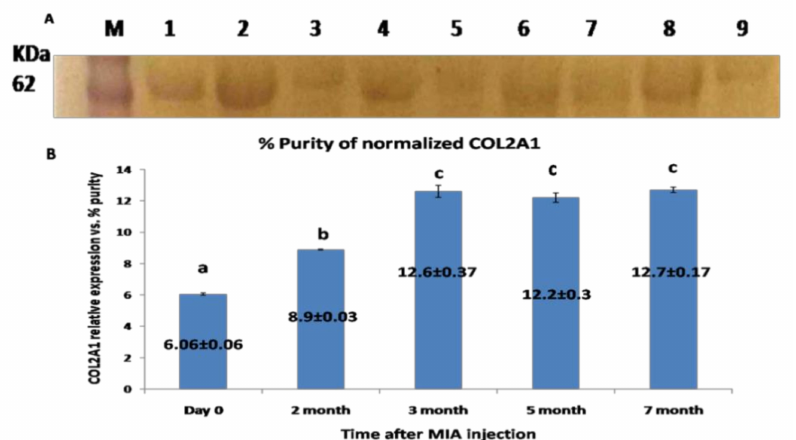
Figure 6. ( A ) Western blot membrane representing the specific band for COL2A1 protein from the synovial fluid; located at MWT, about 65 KDa. (M): pre-stained protein marker; lanes 1, 2 representing samples at day 0 (control); lanes 3, 4 representing samples for the 2nd month; lane 5: samples at the 3rd month; lanes 6 and 7 samples at the 5th month; and lanes 8 and 9 corresponding to the 7th month. ( B ) Graphical representation for the level of COL2A1 protein expression level relative to total protein Coomassie blue staining) as quantified by densitometric analysis of the bands. Data presented as the mean ± SEM for triplicate samples ( n = 3). Values with the same letters are non-significantly di ff erent ( p > 0.05) while the values of di ff erent letters are significantly di ff erent ( p <